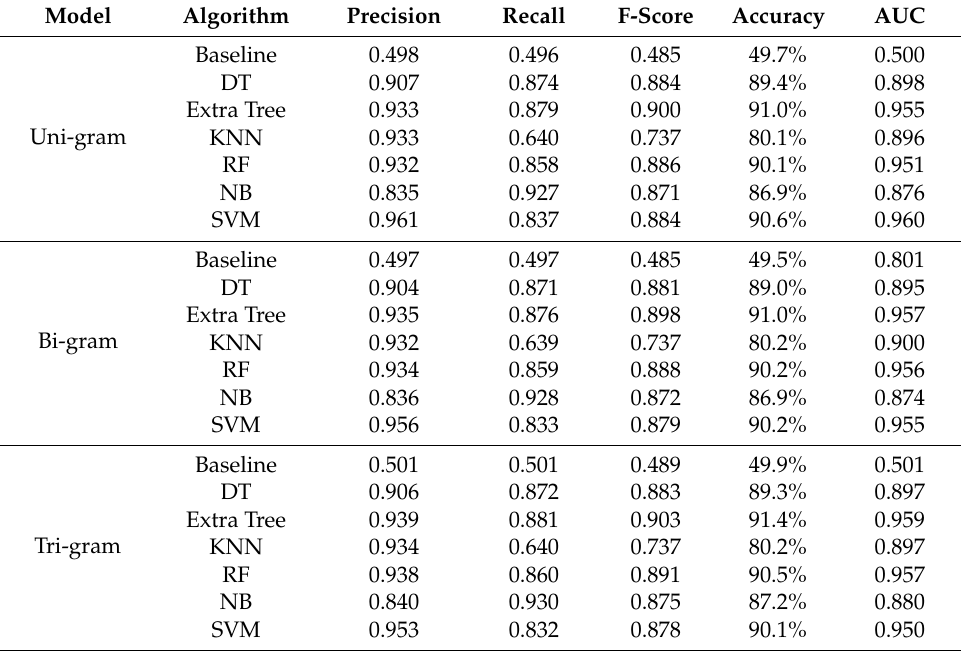
Table 6. Evaluation of classification algorithms with n-gram models on the training dataset.